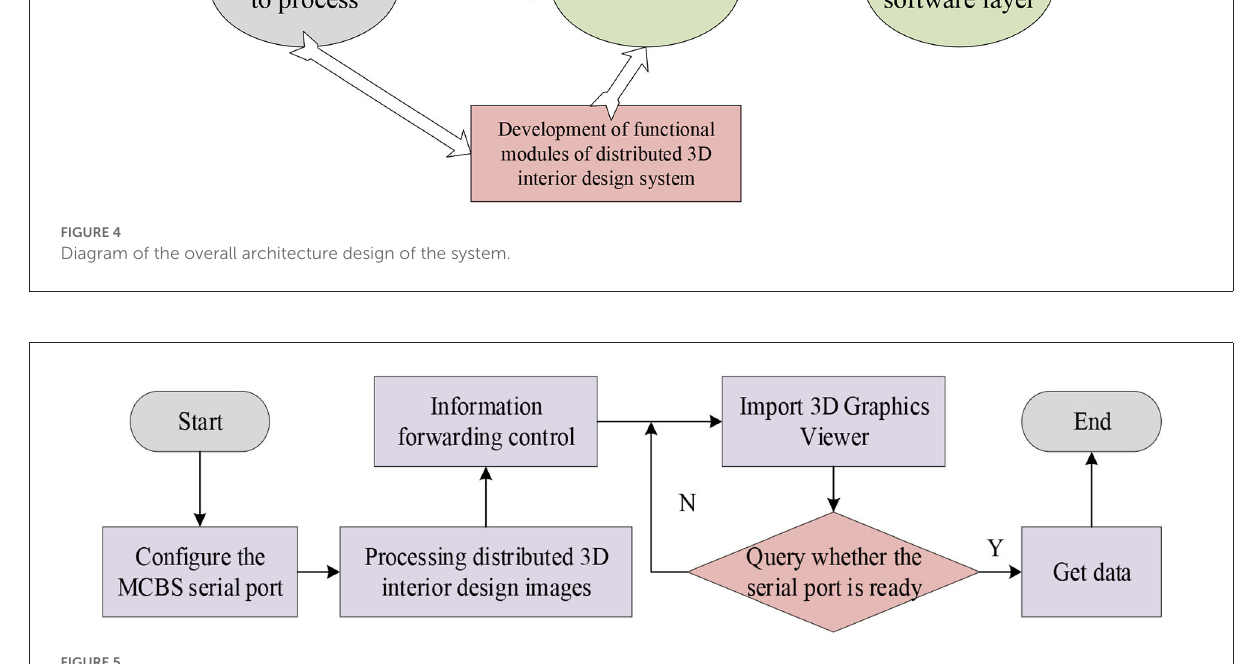
FIGURE5 Development and realization process of distributed 3D interior design